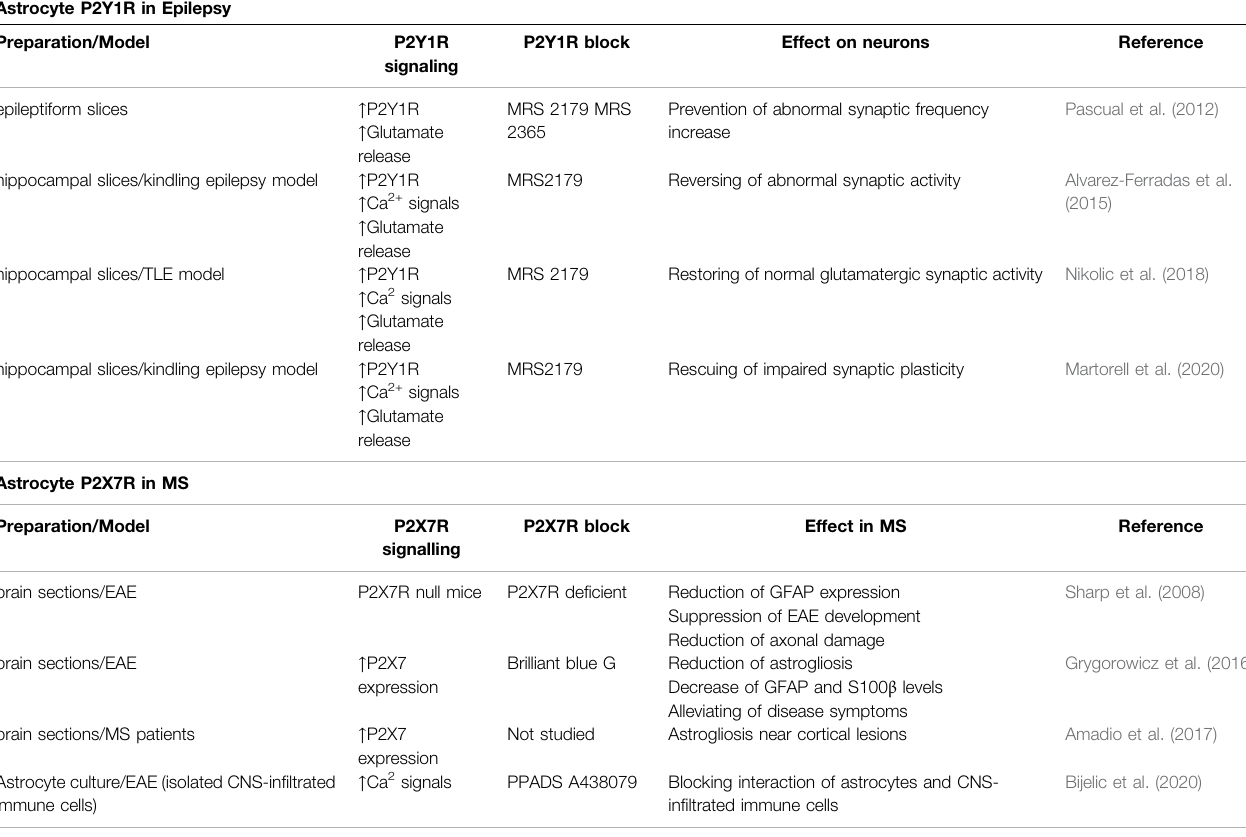
TABLE 1 | Examples of astrocyte P2Y1R- and P2X7R-mediated signalling in epilepsy and MS, respectively. Properties of astrocyte P2Rs-mediated signalling and effects of their blocking on pathophysiological events are showed for both diseases. Astrocyte P2Y1R in